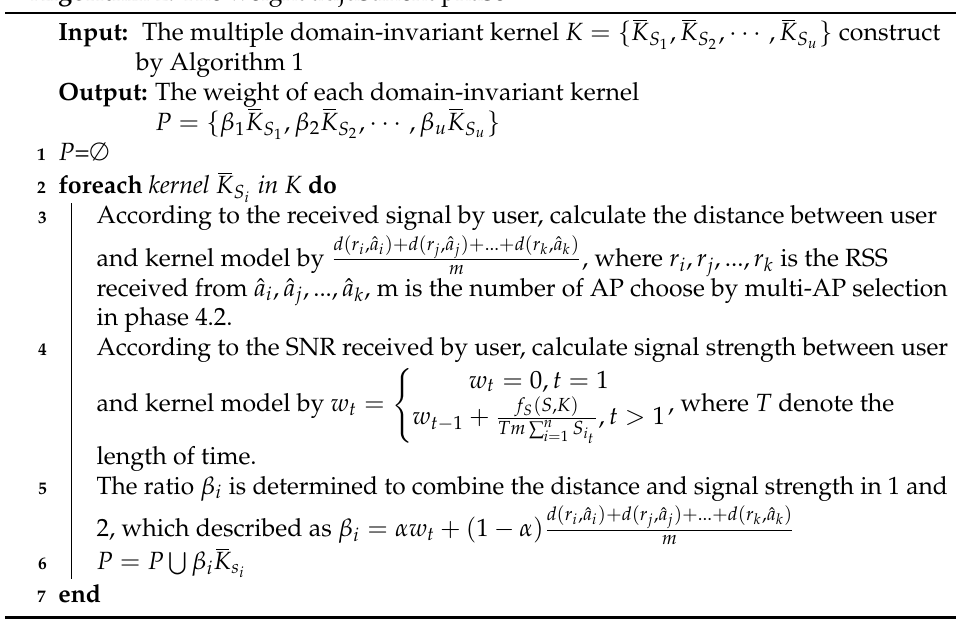
Algorithm 2: The weight adjustment